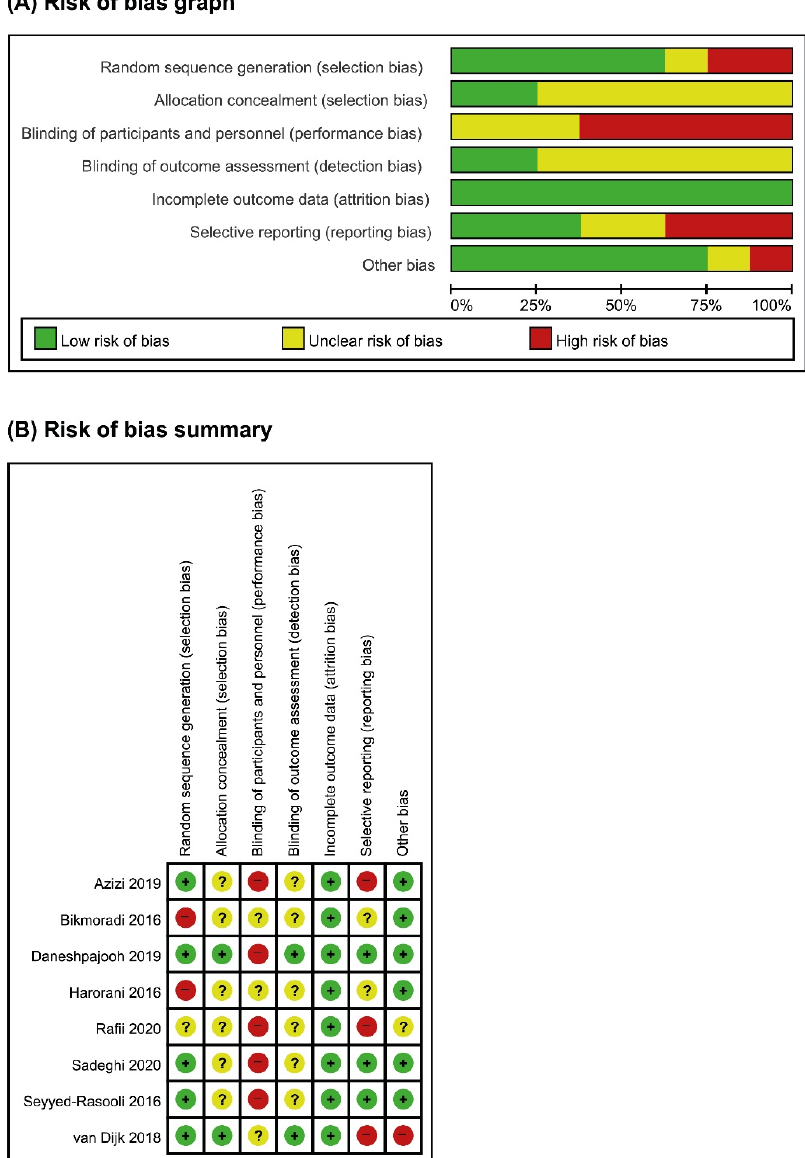
Figure 2. ( A ) Risk of bias graph: review authors’ judgments about each item’s risk of bias item presented as percentage across all included studies; ( B ) risk of bias summary: review authors’ judgments about each item’s risk of bias for each included study (+, low risk; ?, unclear; − , high risk).